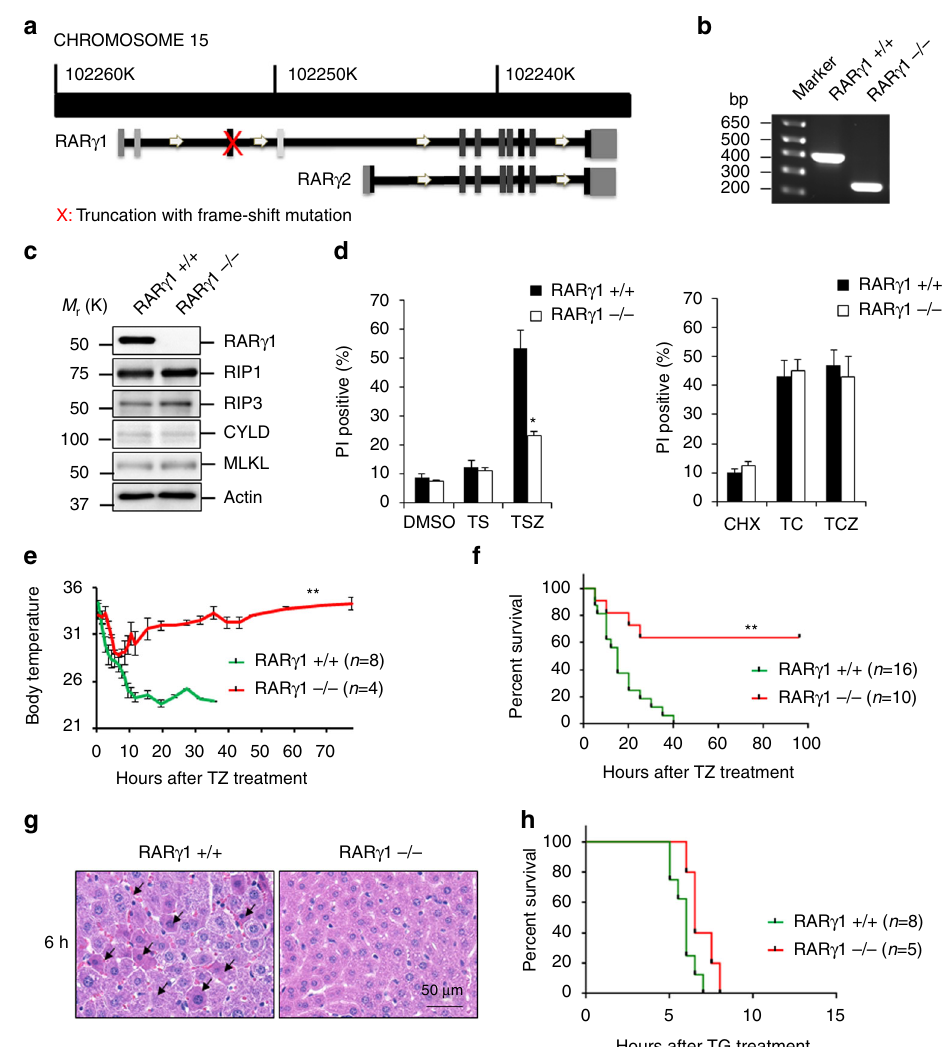
Fig. 7 RAR γ -null MEFs and mice are protected against TNF-induced death. a Scheme for making CRISPR-knock-out (RAR γ − / − ) mice. b PCR analysis of genomic DNA from wild-type (RAR γ +/+) and homozygous CRISPR-knock-out (RAR γ − / − ) mice. c MEFs from RAR γ +/+ and RAR γ − / − littermates were generated and analyzed by immunoblotting using indicated antibody. d Primary RAR γ +/+ and RAR γ − / − MEFs were treated with DMSO, TS or TSZ for 24 h ( left panel ) or with CHX, TC or TCZ for 24 h ( right panel ). Cell death was determined by PI staining using fl ow cytometry. e , f Body temperature curve e ; or survival curve f of wild-type ( green : RAR γ +/+) and CRISPR-knock-out ( red : RAR γ − / − ) mice after treatment with z-VAD-fmk and TNF- α (TZ). (** P < 0.001 versus RAR γ +/+; Student ’ s t -test for e ; log rank test for f . g Livers were excised from RAR γ +/+ and RAR γ − / − mice 6 h after TZ treatment. Representative histologic H&E staining of liver shows focal necrotic cells and red blood cells ( arrow ) ( scale bar : 50 μ m). h Survival curve of wild-type ( green : RAR γ +/+) and CRISPR-knockout ( red : RAR γ − / − ) mice after treatment with treatment with GalN and TNF- α (no signi fi cance; log rank test). Mouse number used in each experiment was indicated. All blots and gel above are representative of one of three experiments (Fig. 7d) and the immortalized RAR γ 1 − / − MEFs were resistant mice recovered (Fig. 7e). The wt mice succumb by 24 – 36 h, to both TS- and TSZ-induced cell death (Supplementary Fig. 18a) whereas 60% of the RAR γ 1 − / − mice survive up to 4 days (Fig. 7f). con fi rming the results obtained with RAR γ -shRNAs. In addition, When these mice were examined 6 and 12 h after treatment, we fi nd that hematoxylin and eosin staining of the liver showed RAR γ 1 deletion also protects the primary BMDMs cells from TSZ-induced necroptosis (Supplementary Fig. 18b). Next we focal necrotic cells in wt mice, evidenced by pyknotic nuclei used a mouse model of systemic in fl ammation that and eosinophilic cytoplasm whereas the RAR γ 1 − / − livers had resembles clinical sepsis to examine the role of RAR γ in cell signi fi cantly less necrosis (Fig. 7g and Supplementary Fig. 19). death in vivo. It has been demonstrated that inhibition of Interestingly, both wt and RAR γ 1 − / − mice have similar caspases by z-VAD-fmk strongly sensitizes mice to TNF-induced mortality in the TNF-induced, TRADD-mediated cell death shock involving RIP1/RIP3-dependent necrosis 45 . The wt and model when mice were treated with TNF and D-galactosamine RAR γ 1 − / − littermates were injected with a combination of TNF α (G), which is a metabolic inhibitor of transcription (Fig. 7h) 46, 47 . and z-VAD-fmk (TZ). We monitored the body temperature of In addition, TRADD − / − mice were not resistant to TZ-induced the mice for 72 h and although both wt and RAR γ 1 − / − lethality (Supplementary Fig. 20). These results suggested that littermates had similar hypothermia initially, the wt mice had RAR γ has a critical role in RIP1/RIP3-mediated necroptosis, but continued drop in body temperature whereas most RAR γ 1 − / − not TRADD-mediated cell death in vivo. NATURE COMMUNICATIONS | 8: 425 | DOI: 10.1038/s41467-017-00496-6 |